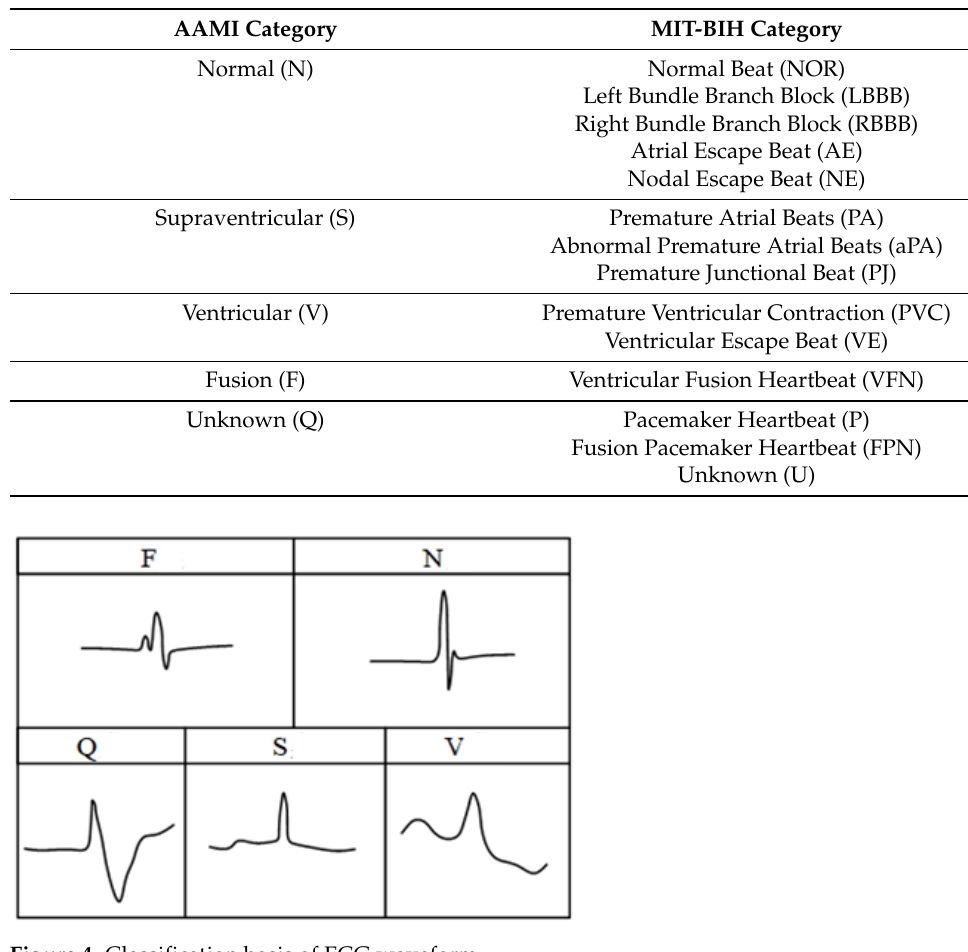
Table 1. AAMI classification standard of MIT-BIH database.